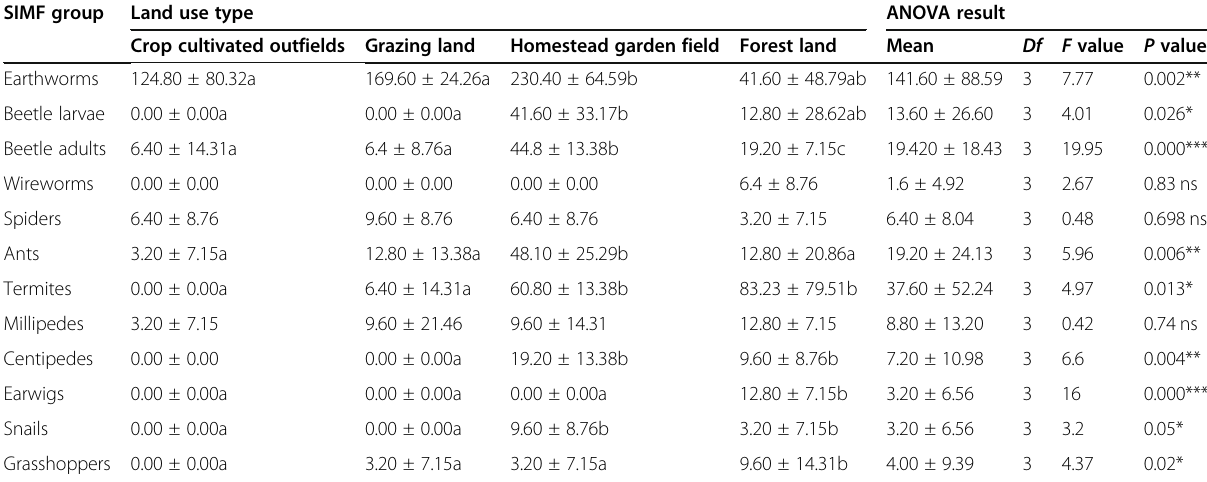
Table 3 mean density (individuals/m 2 ) with standard deviation of SIMF sampled at Shenkolla watershed SIMF group Land use